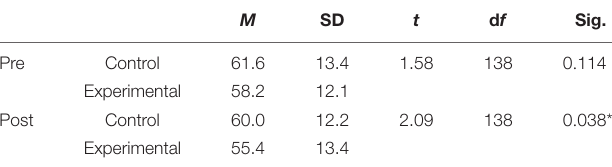
TABLE 3 | Foreign Language Test Anxiety Scale (FLTAS) independent samples T -test results.